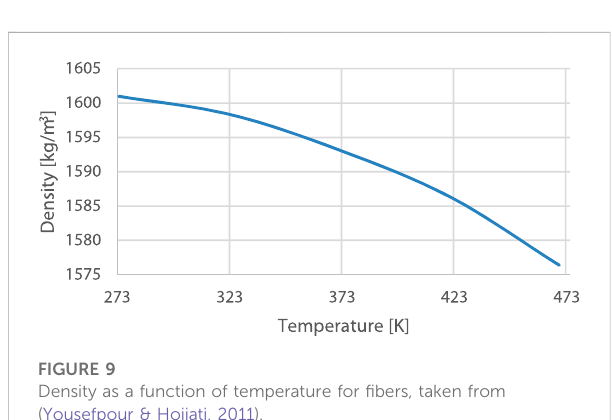
FIGURE 9 Density as a function of temperature for fi bers, taken from (Yousefpour & Hojjati, 2011).